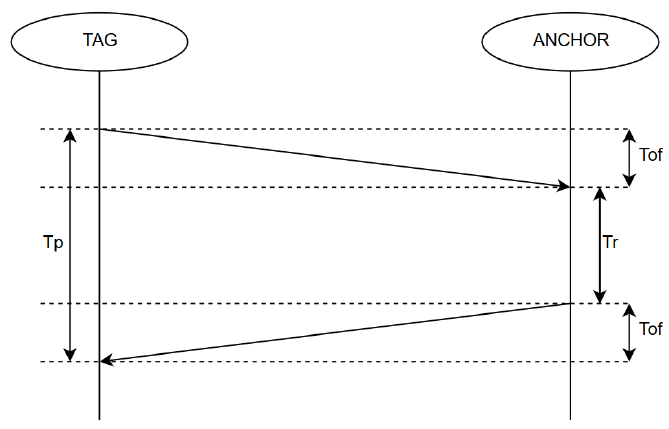
Figure 5. The principle of determining the relative position between anchor and tag.